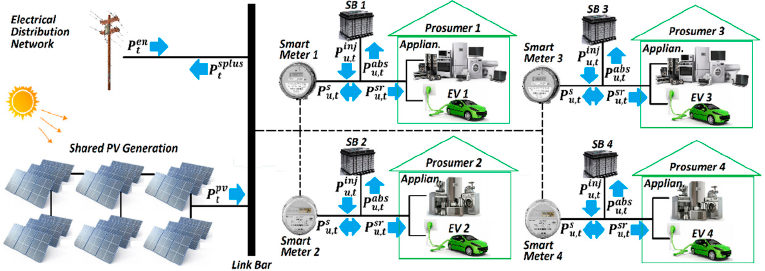
Figure 1. The daily operational performance of the prosumers community. Table 1. Technical Data related to Home Appliances with 𝛽 (cid:3028) = 1.